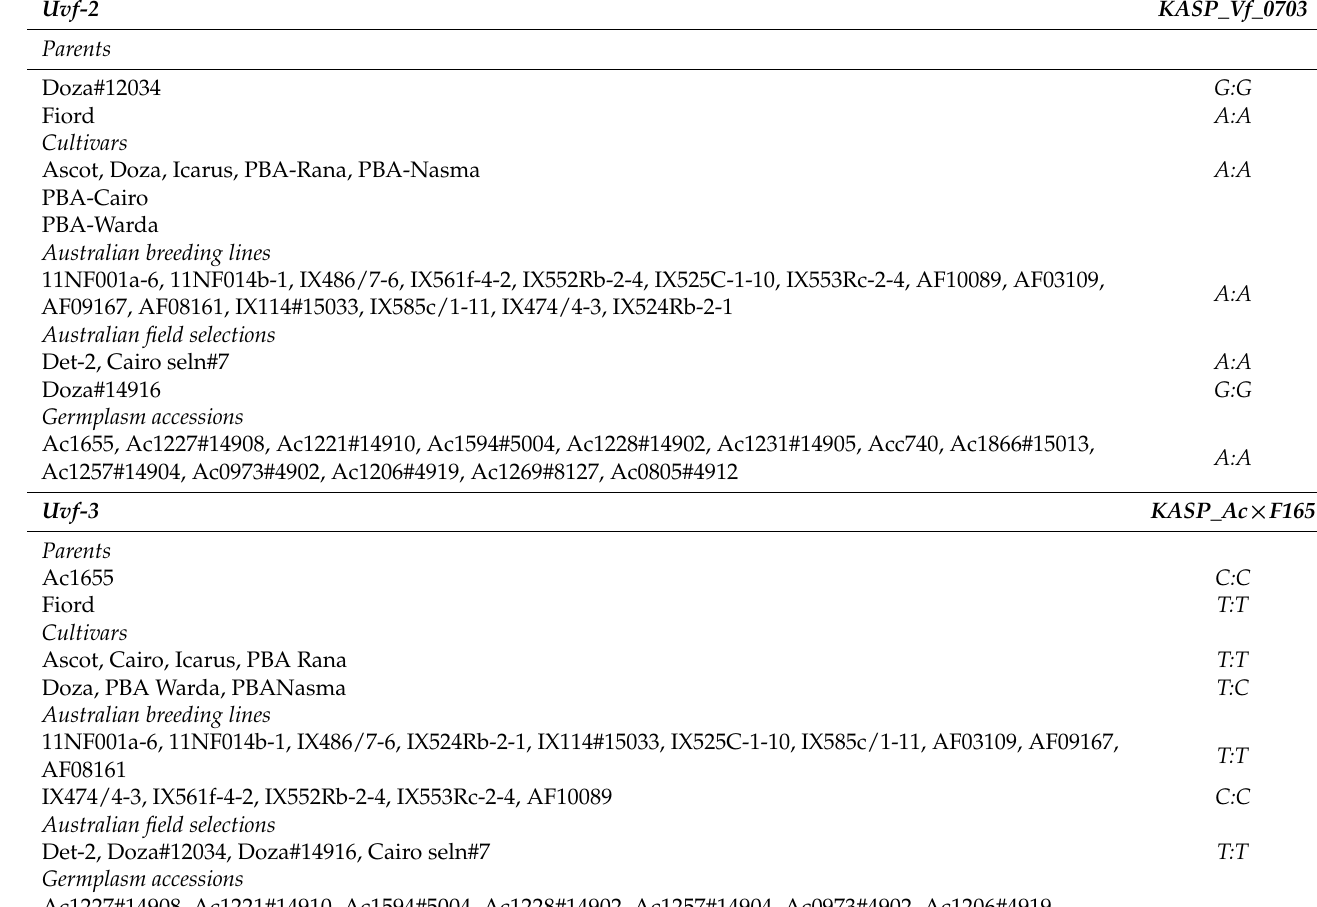
Table 2. Validation of Uvf-2 and Uvf-3 -linked KASP markers on a set of local and exotic